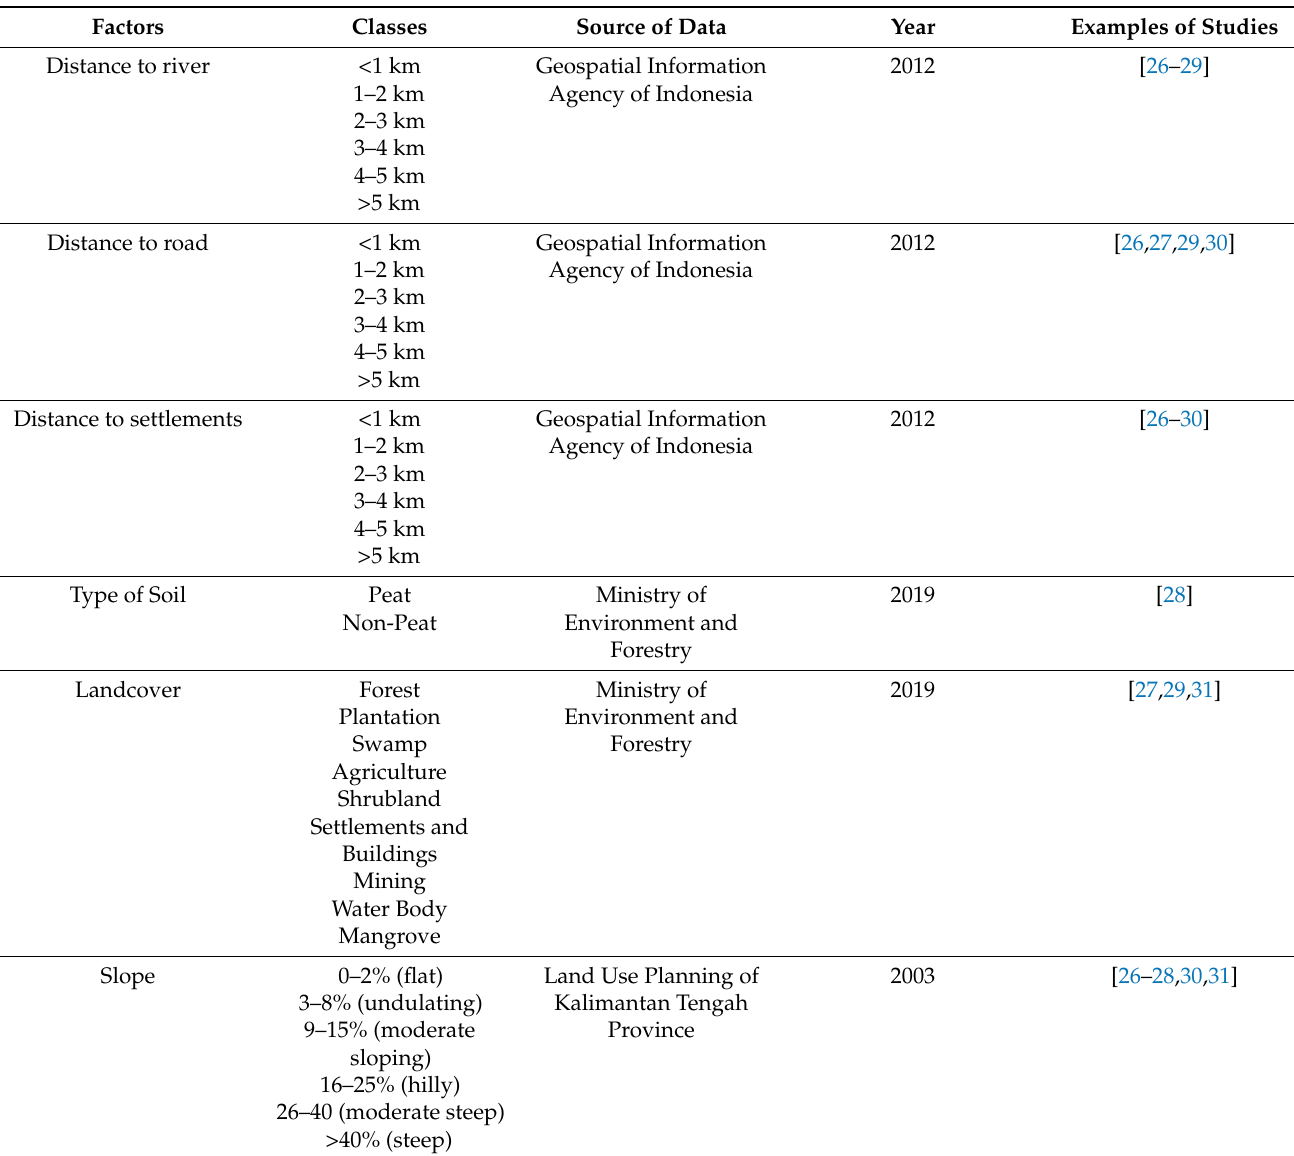
Table 1. Data required for the forest and land fire susceptibility